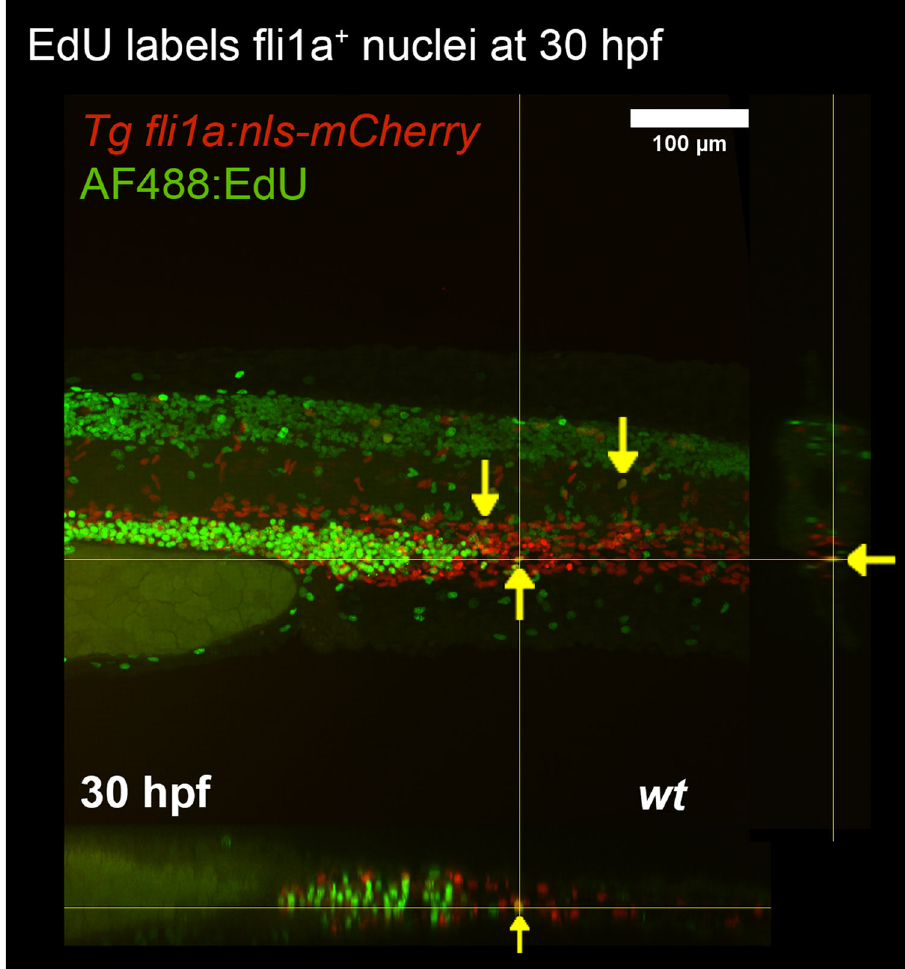
Figure 3. EdU labelling of zebrafish larvae. Proliferating ECs of Tg ( fli1a:nls-mCherry ) embryos were labelled using EdU and visualised using EdU-binding fluorescent azide. Proliferating endothelial nuclei are marked (yellow arrows).Orthagonal views are presented for the X and Y